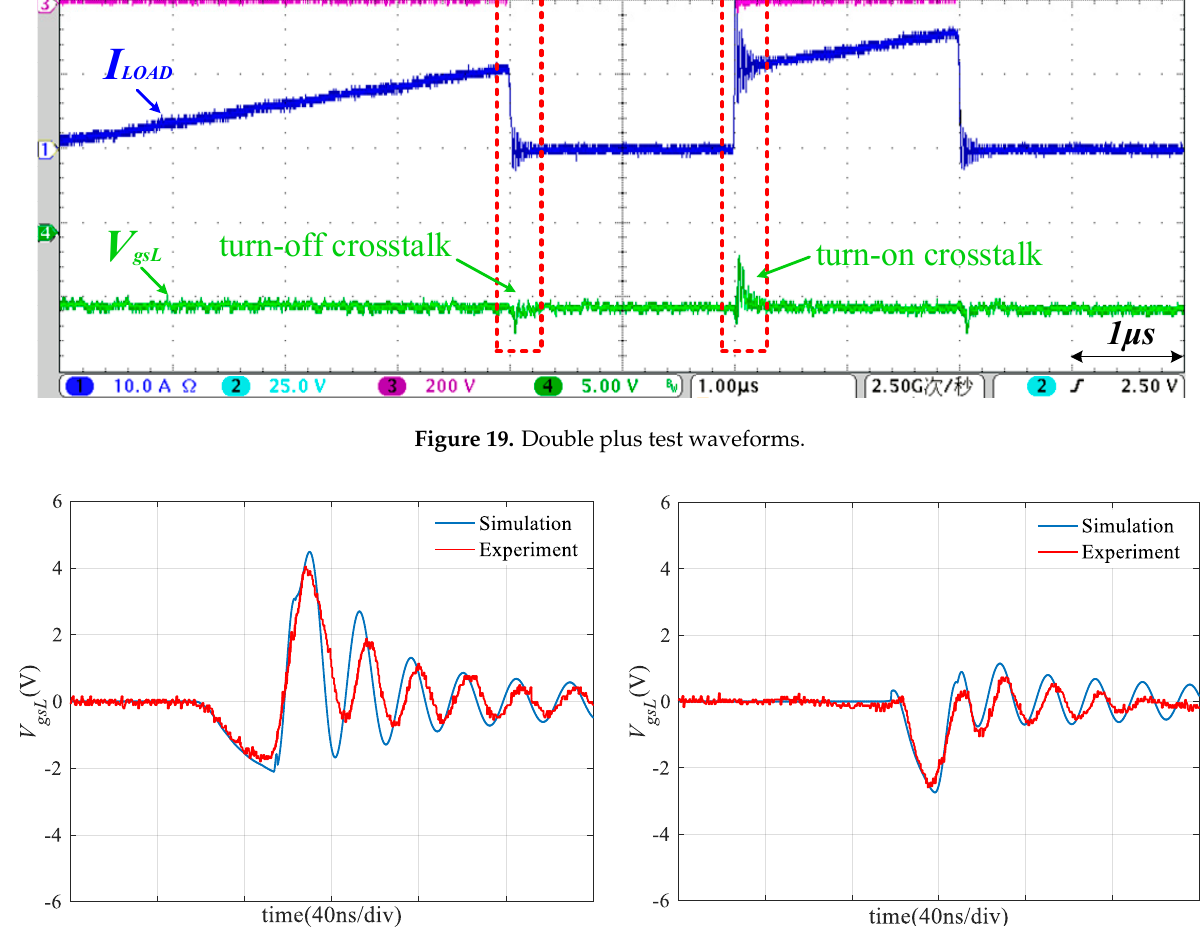
Figure 20. Comparison of simulation and experimental waveforms of crosstalk in ( a ) turn-on process, ( b ) turn-off process. It is apparent that the proposed analytical model is more detailed and matches better with the experimental results (in terms of the voltage drop in Stage 2, the oscillations after the voltage switching, and the peak values response) than models in Refs. [17,24].